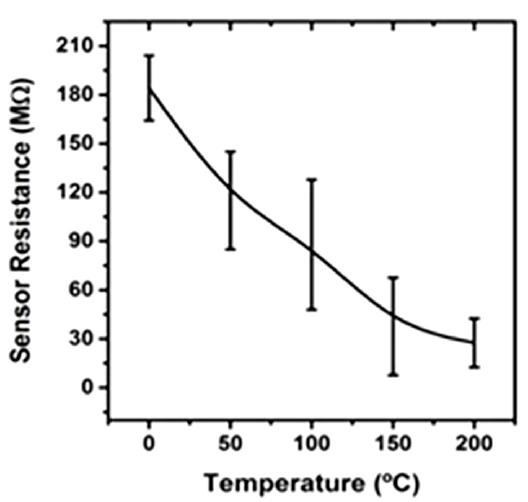
Figure 10. Sensor resistance of a single NW from Sample A (at a fixed current of 5 nA) as a function of the heater temperature.